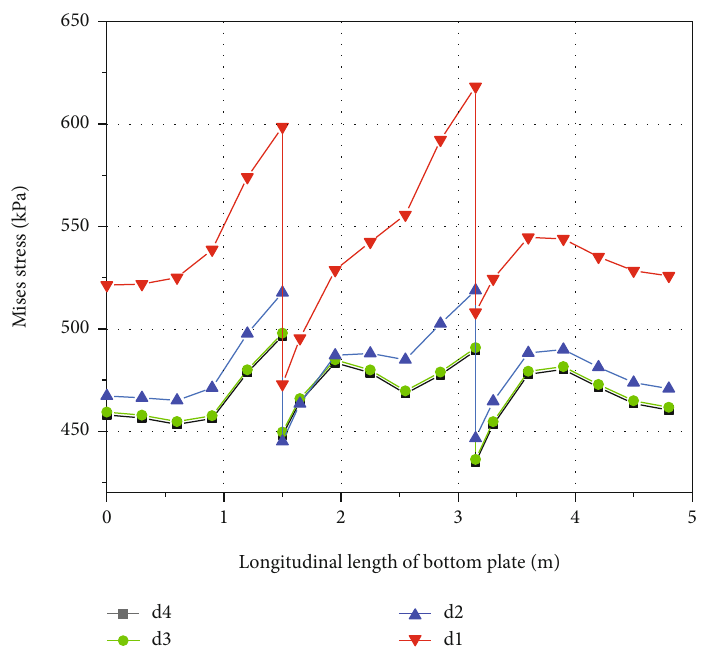
Figure 15: Longitudinal distribution curve of Mises stress on the bottom plate of integrated pipe